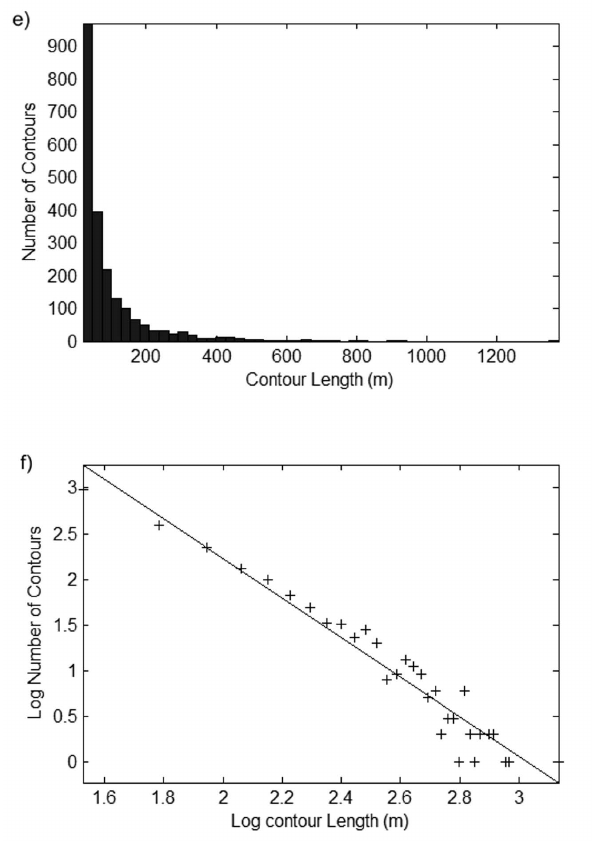
Fig. 1e, f. Histogram and log-log histogram of the lengths of the edge contours obtained from the gravity response from 50000sources at a depth of 5m. A fitted power–law distribution is shown as a solid line.